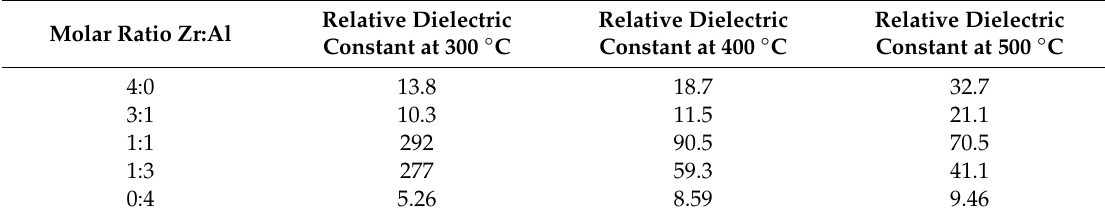
Figure 8. The capacitance of the ZAO films with altering ratios annealed at: ( a ) 300 °C; ( b ) 400 °C; and ( c ) 500 °C; as well as ( d ) the relative dielectric constants of the ZAO films changing with the mixing ratio of zirconia and alumina annealed at 400 and 500 °C. Table 3. The relationship among the thin film relative dielectric constants, mixing ratio and annealing